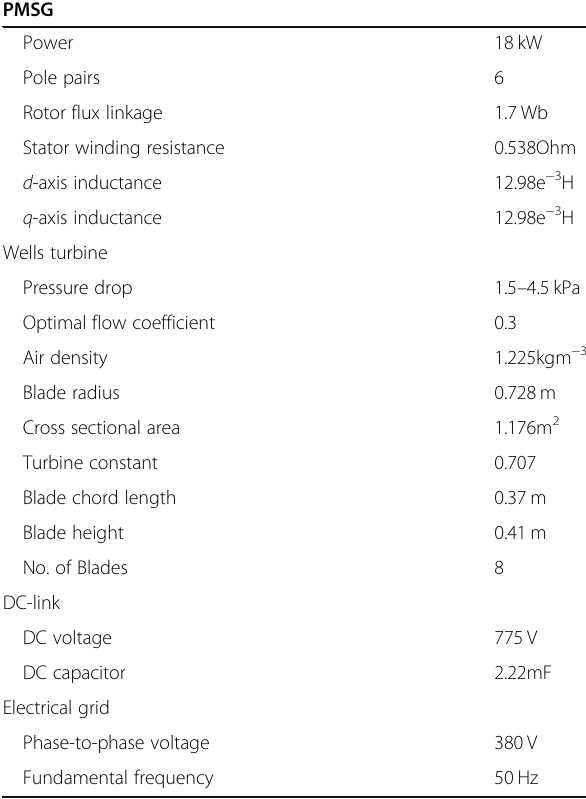
Table 4 The parameters and operating